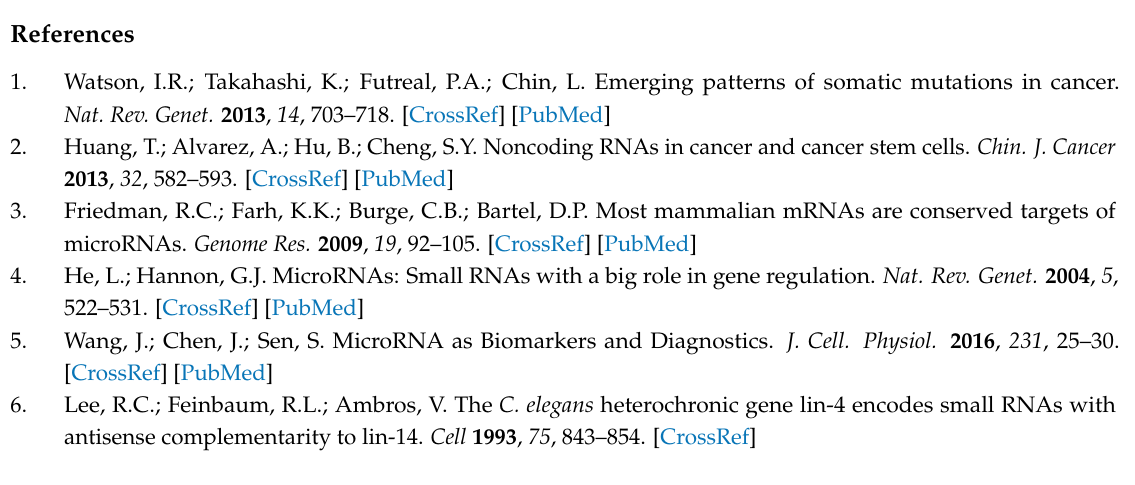
Table S1: List of cancer genes used in this study and their